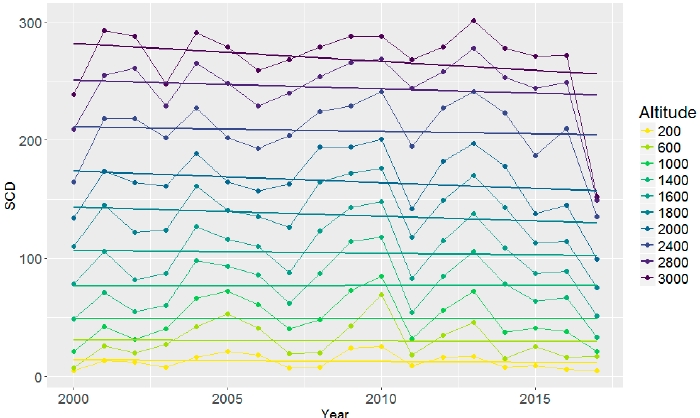
Figure 10 : Yearly median SCD of the Alps in ten different altitudes over the years 2000–2017.